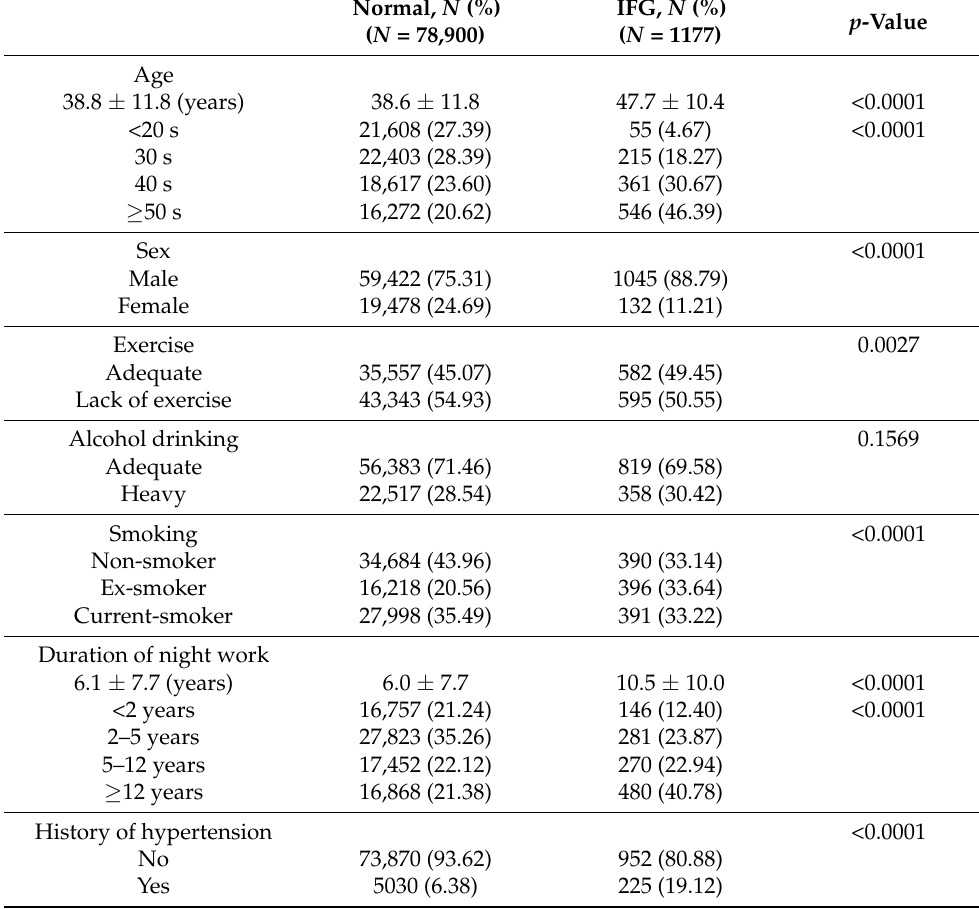
Table 1. General characteristics of participants who underwent the SHEW.